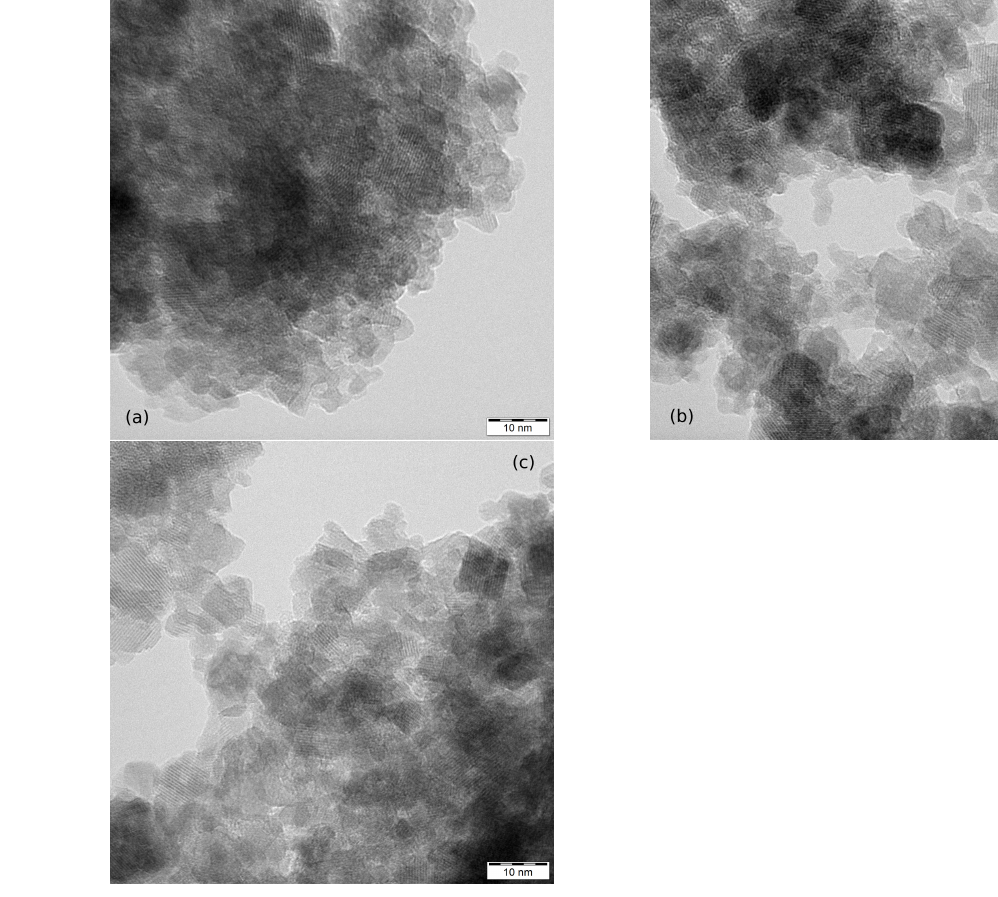
Figure 4. TEM images of measured nanoparticles and their aggregates: ( a ) MW-5, ( b ) MW-10 and ( c )